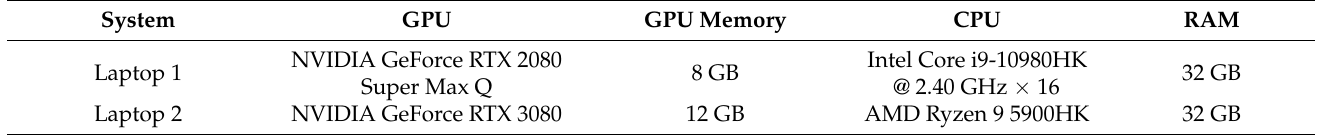
Table 3. Hardware specifications for two laptop computers used for this